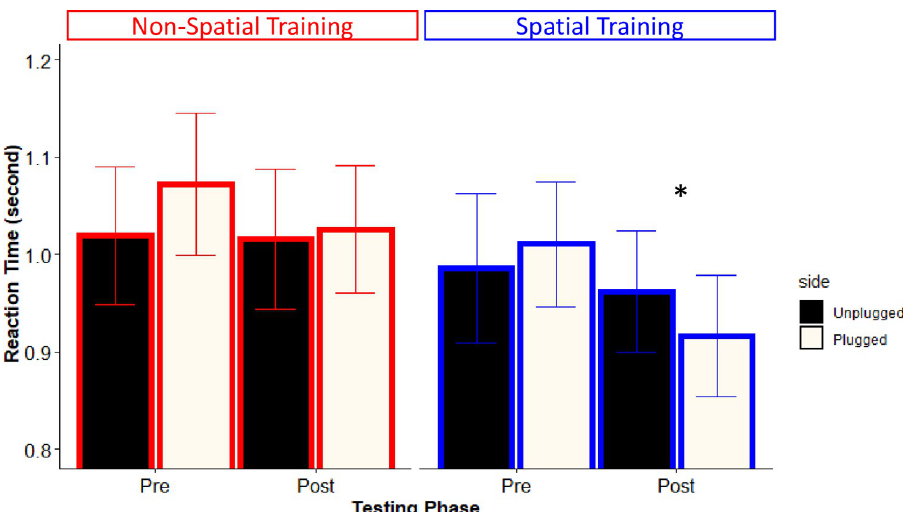
Fig 7. Reaction Time, RT, in seconds as a function of training type (Non-Spatial or Spatial) phase (pre and post training), separately for sound delivered to the left (black) or to the right (white) of participant’s midline. Error bars indicate the standard errors. In all comparisons RTs for right targets are significantly slower than those for left targets, except in the post phase of the Spatial training. In the latter case the RT pattern is significantly reversed (marked by an